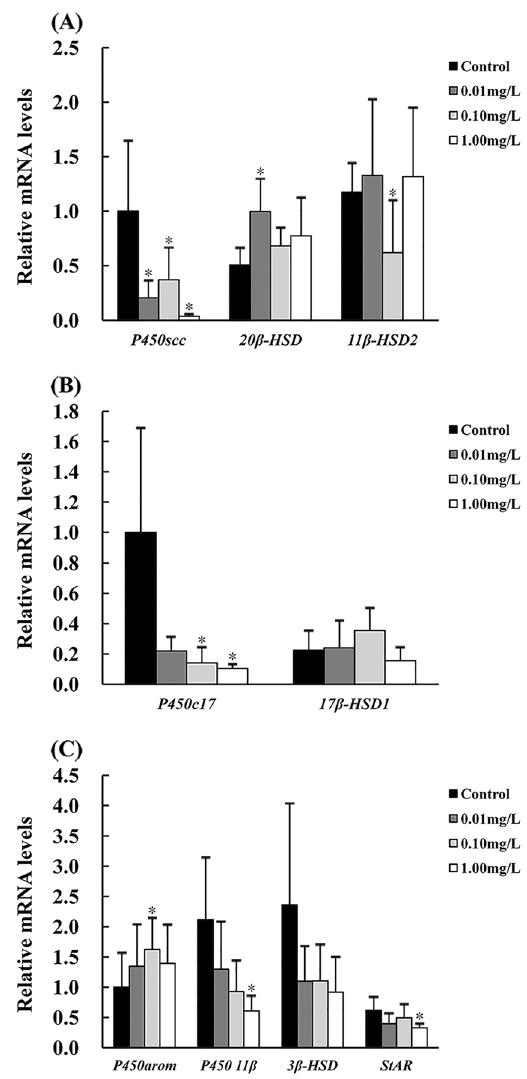
Figure 3. Effects of MCP pesticide on testicular transcriptional levels of StAR and steroidogenesis enzymes in male goldfish ( Carassius auratus